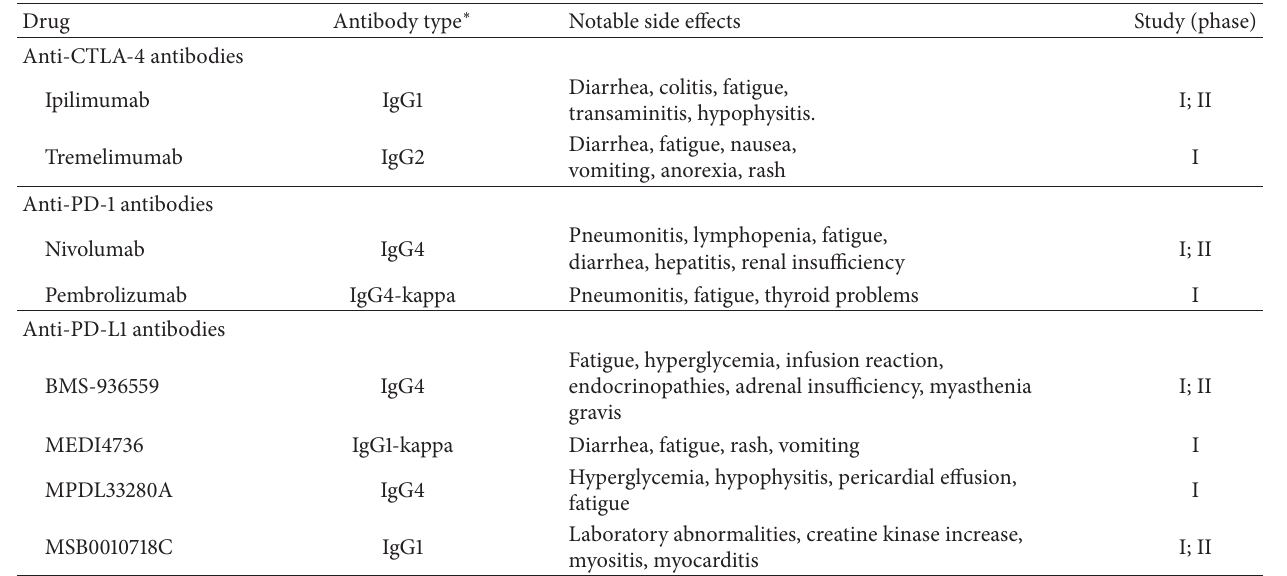
Table 1: Active trials of checkpoint inhibitor in ovarian